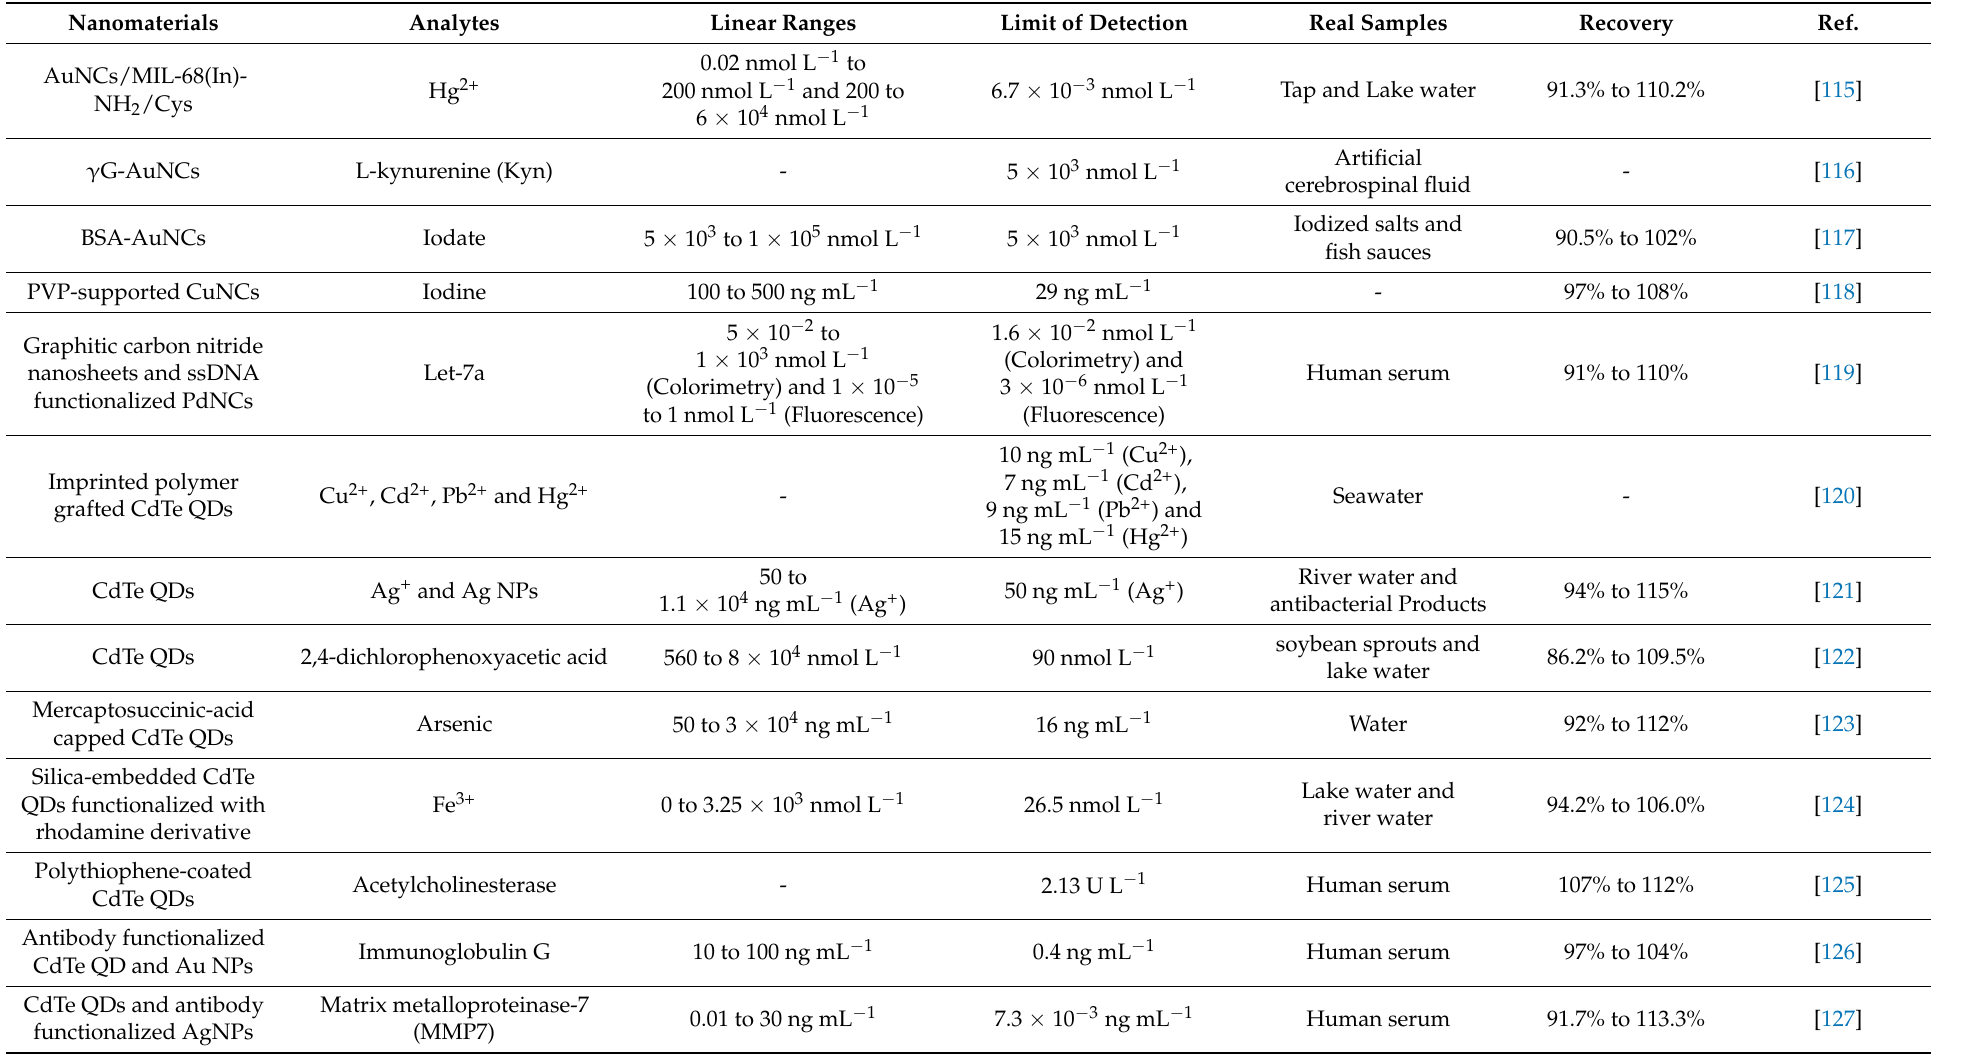
Table 3. The typical nanomaterial-enhanced fluorescent PADs for sensing various